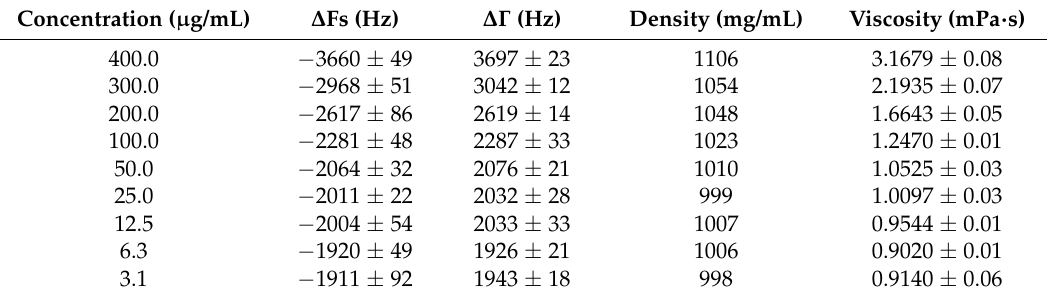
Table 2. Glycerol solutions results (average ± SD).